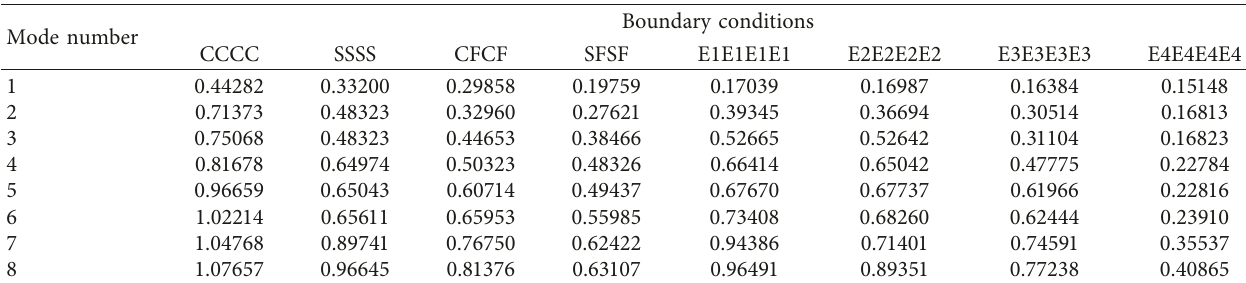
Figure 6: First three modes shapes of the experiment: (a) first mode shape; (b) second mode shape; (c) third mode Table 8: First eight frequency parameters Ω of an orthotropic plate with different boundary conditions ( h / a � 0.3).